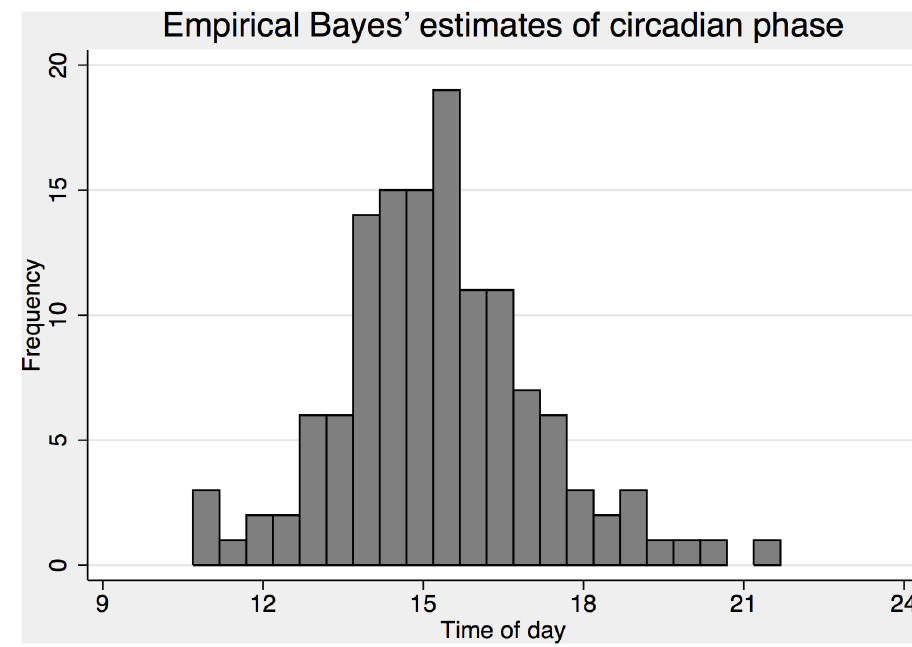
Figure 6. Empirical Bayes’ estimates of all subjects circadian phase based on equation 13.